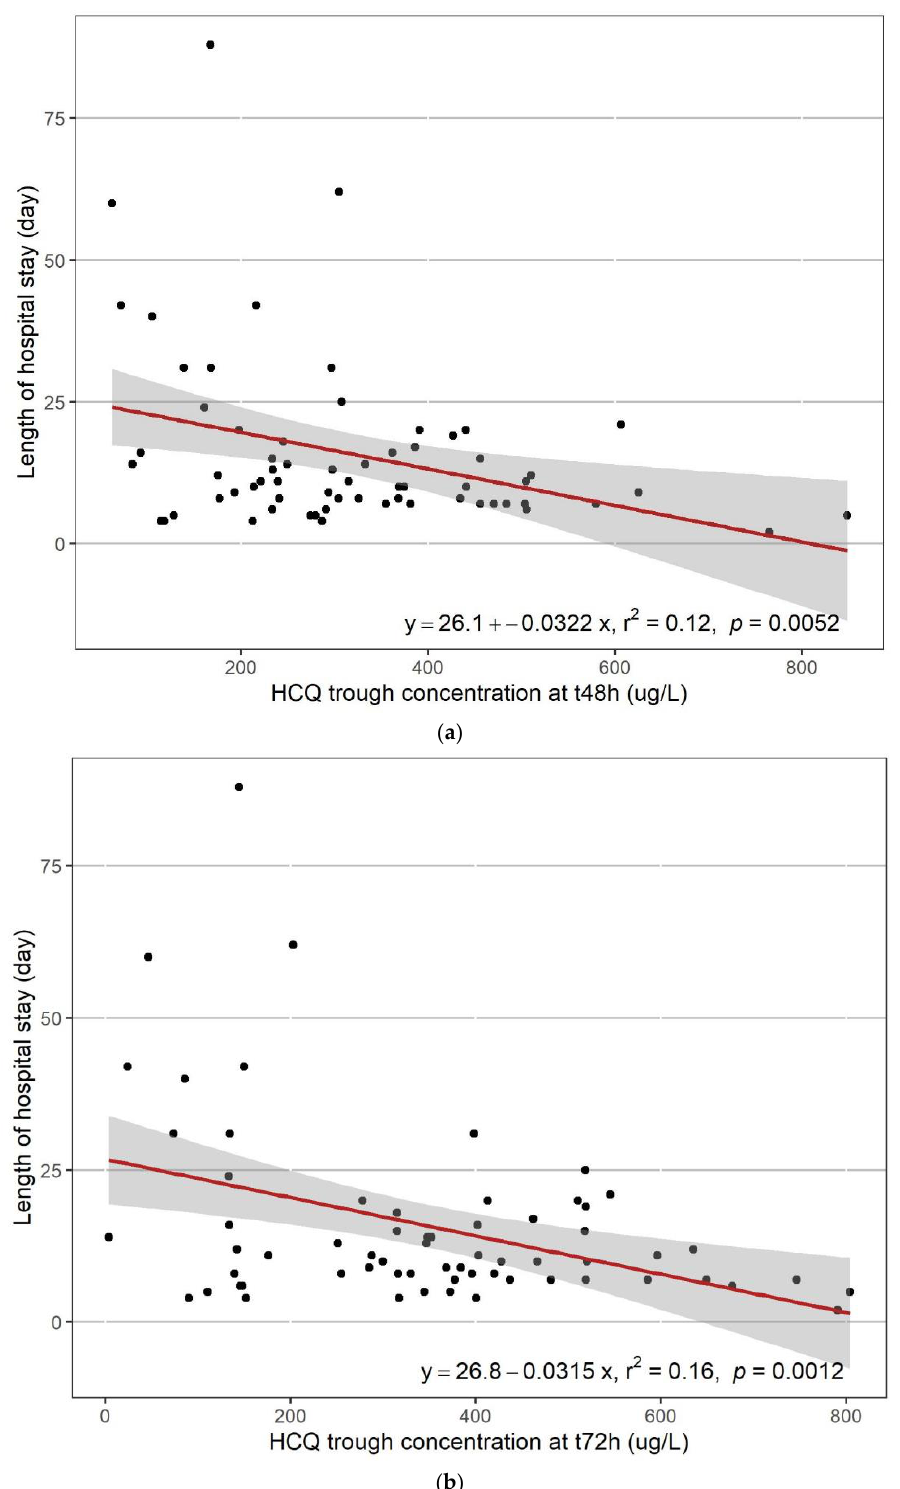
Figure 5. Length of stay versus HCQ blood trough concentrations at t48 h ( A ) and t72 h ( B